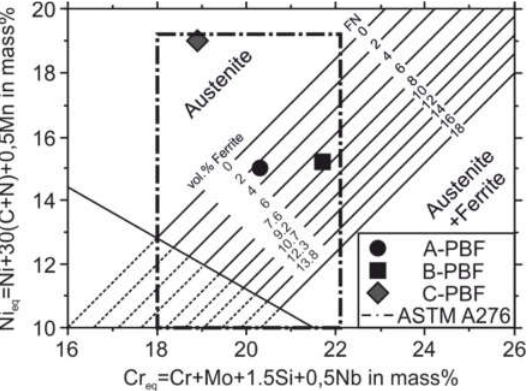
Figure 8. Representation of the DeLong diagram according to [1] with positions of the used starting materials.